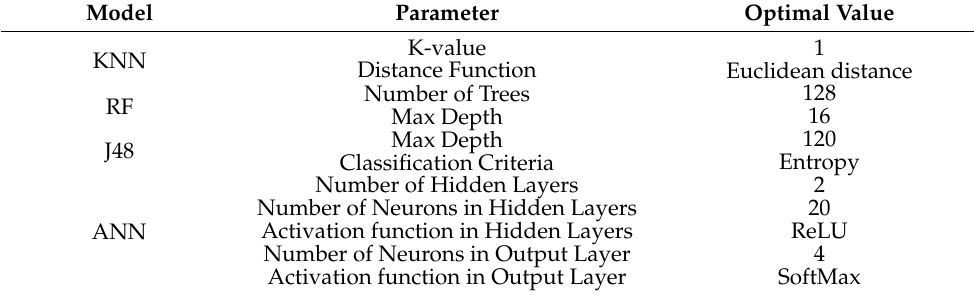
Table 6. Parameters optimization.